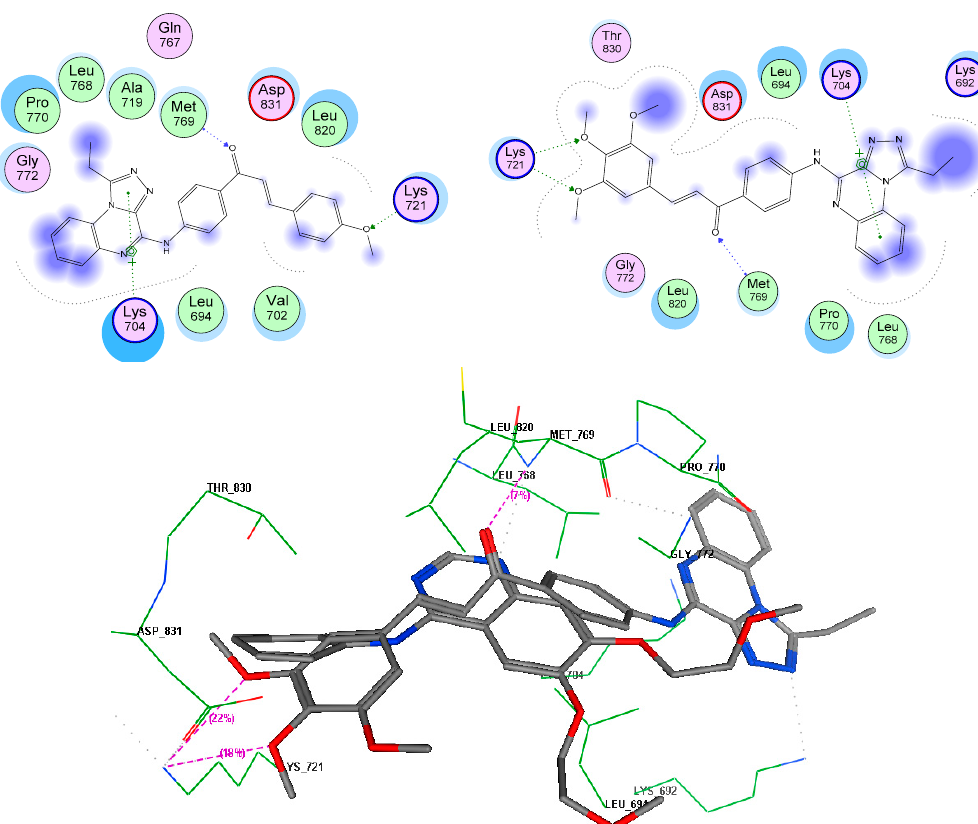
Figure 2. Molecular interaction graph of target compounds 7e and 7g in the EGFR TK ATP pocket. Molecules 2018 , 23 , 48